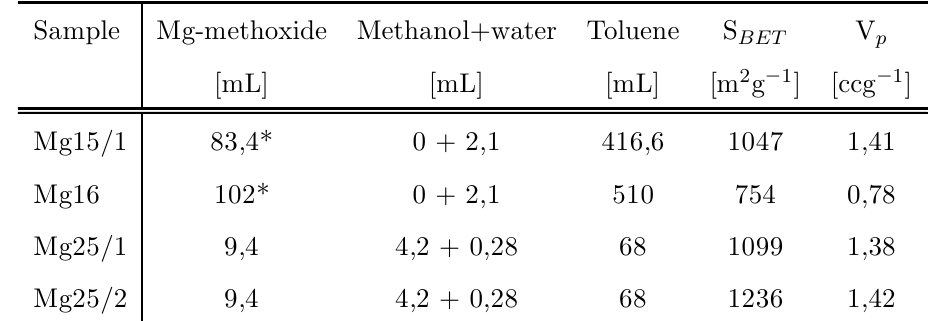
Table 1 Experimental conditions and resulting speci› c surface areas, S volume, V p , of Mg{aerogels prepared from magnesium